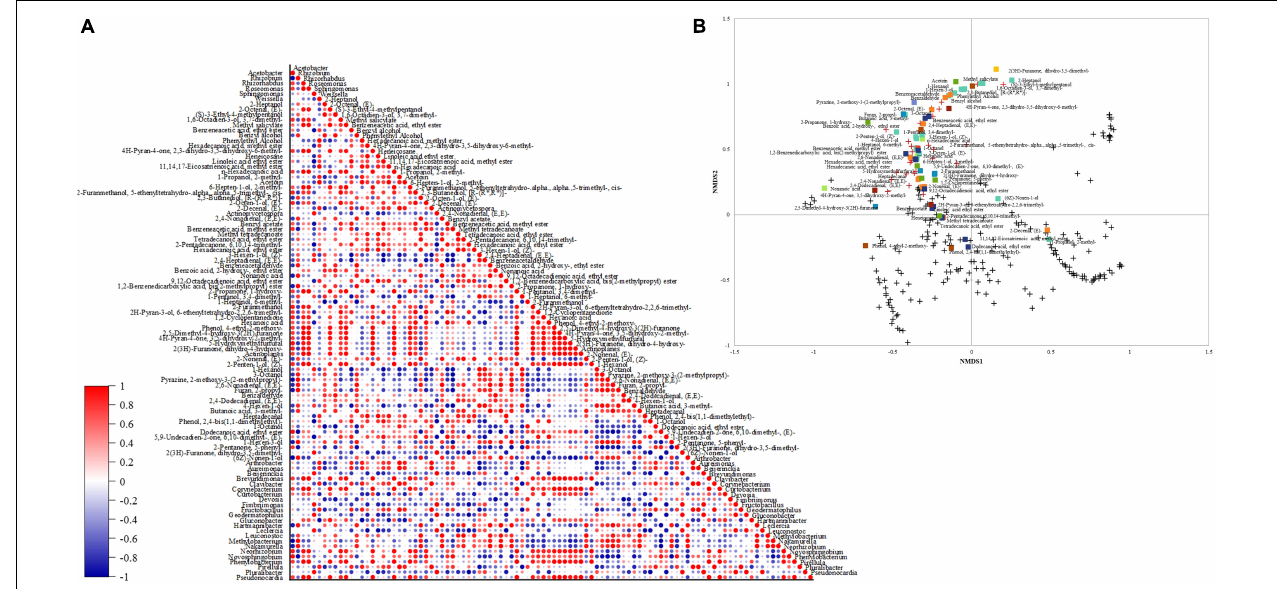
FIGURE 6 | (A) Down-stream Pearson correlation matrix of bacterial genera and volatile compounds. (B) Non-metric scaling (NMDS) using Bray-Curtis dissimilarity for eukaryotic species and volatiles. Volatile groups: (cid:4) acids, (cid:4) alcohols, (cid:4) aldehydes, (cid:4) alkanes, (cid:4) esters, (cid:4) furans, (cid:4) ketones, (cid:4) lactones, (cid:4) phenols, (cid:4) pyrans, (cid:4) pyrazines. + species below 1% and + abundant species above